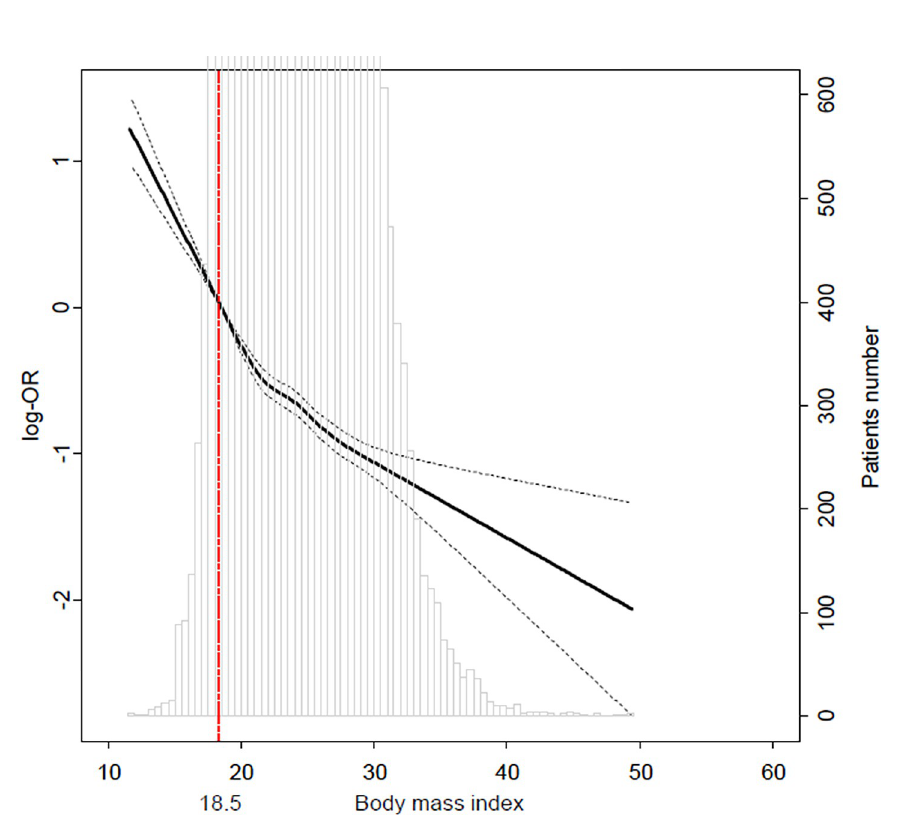
Fig 3. Smooth plot of HRs for mortality during one year according to body mass index.